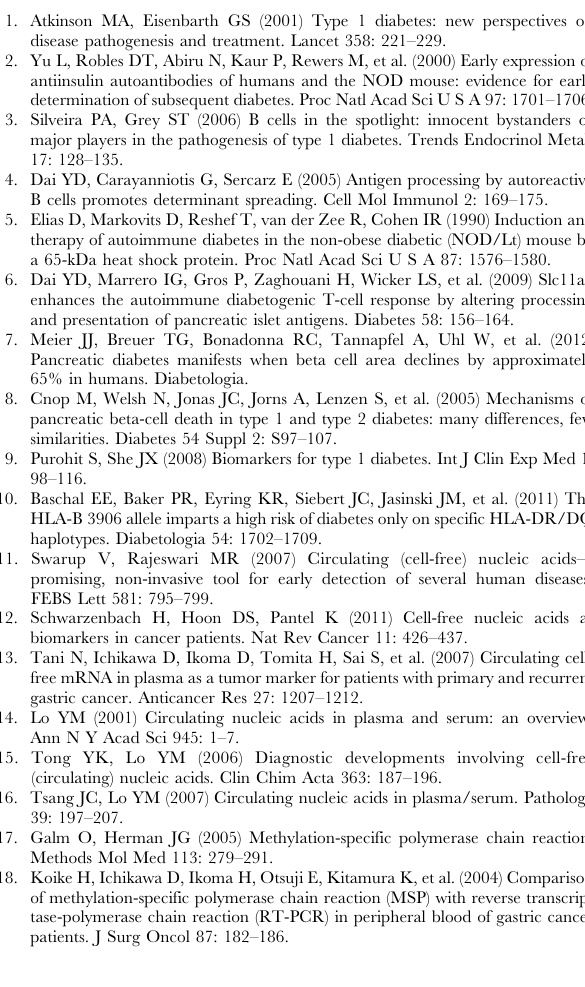
Figure S3 Significant reduction of islet area in